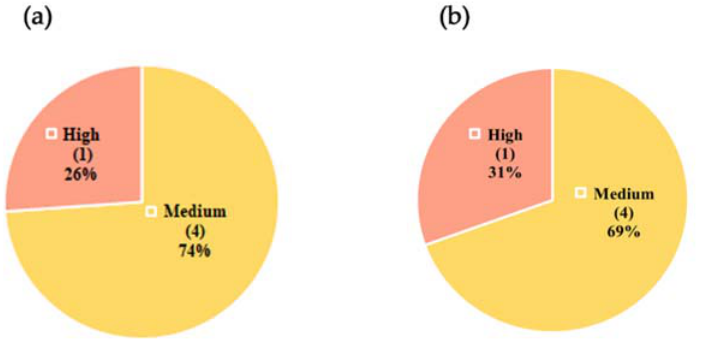
Figure 7. Results of degradation susceptibility (SD) (fragility and vulnerability due to anthropogenic threats) and protection priority of the SGI: ( a ) degradation susceptibility (SD); ( b ) global protection priority (PP).